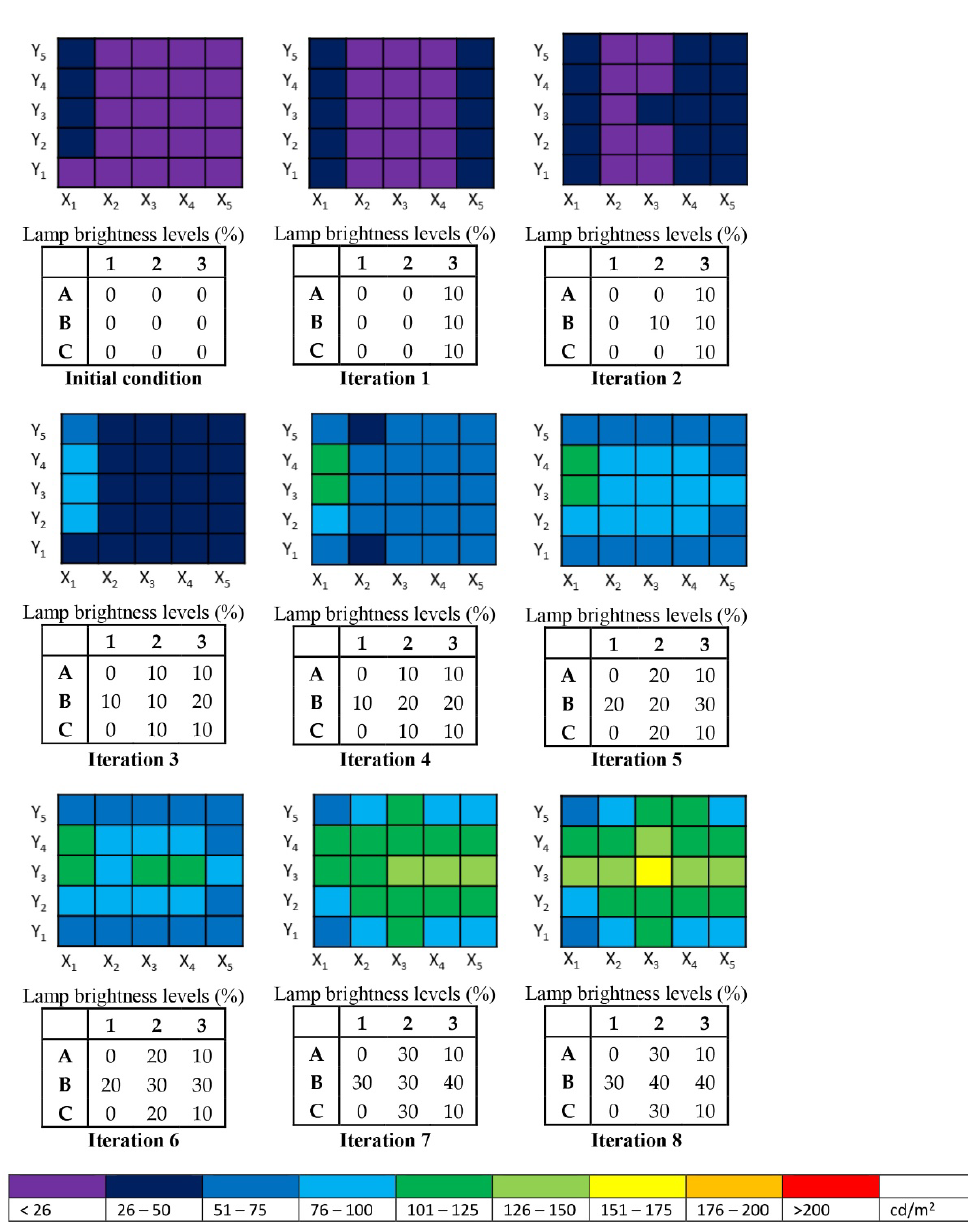
Figure 14. The luminance values and lamp brightness levels for Measurement Scheme 3B. Table 4 summarizes the brightness levels of the lamps in each measurement scheme. The LCS resulted in different combinations of lamp brightness levels for different activi- ties. In Measurement Schemes 1A and 1B, the presence of daylight resulted in a lower brightness level in Measurement Scheme 1B; in Measurement Schemes 2A and 2B, the daylight resulted in the brightness levels of some lamps being lower and those of other lamps being higher than the corresponding levels in the room without daylight, and in Measurement Schemes 3A and 3B, the presence of daylight increased rather than de- creased the brightness levels of some lamps. These results show that daylight presence does not always have a great reducing impact on lamp brightness levels. Despite the pres- ence of daylight in Measurement Scheme 3B, the brightness levels of some lamps are higher in Measurement Scheme 3B than in Measurement Scheme 3A because the activity